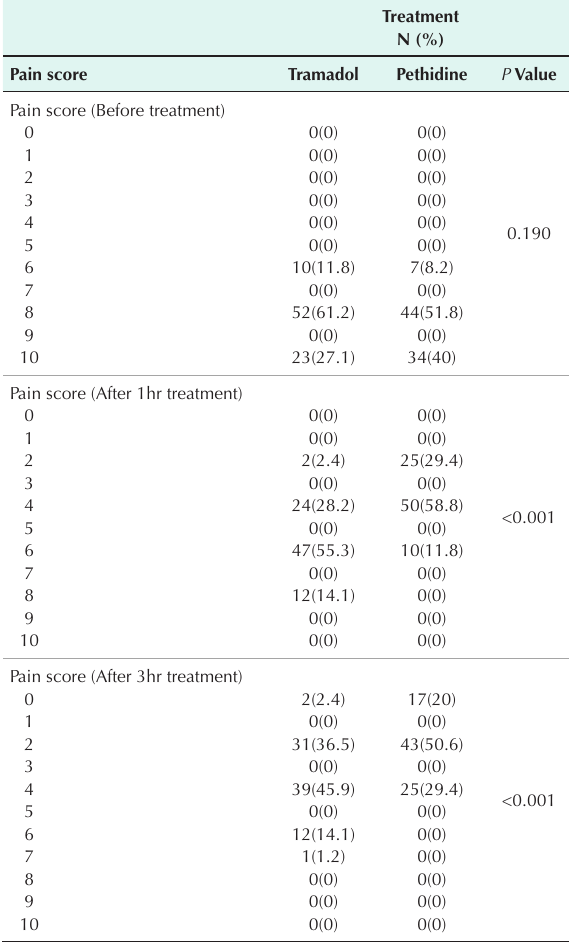
Table 2. Relationship between pain score with treatment.